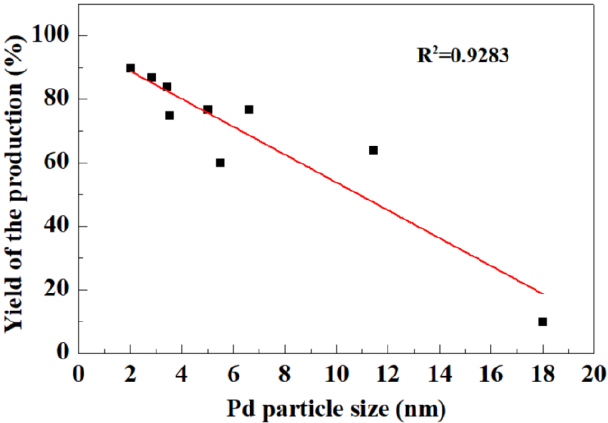
Figure 7. Correlation between the average Pd particle sizes of the three fresh, pre-reduction treated and recovered catalysts with the product yields. The data were from Tables S1 and S6.